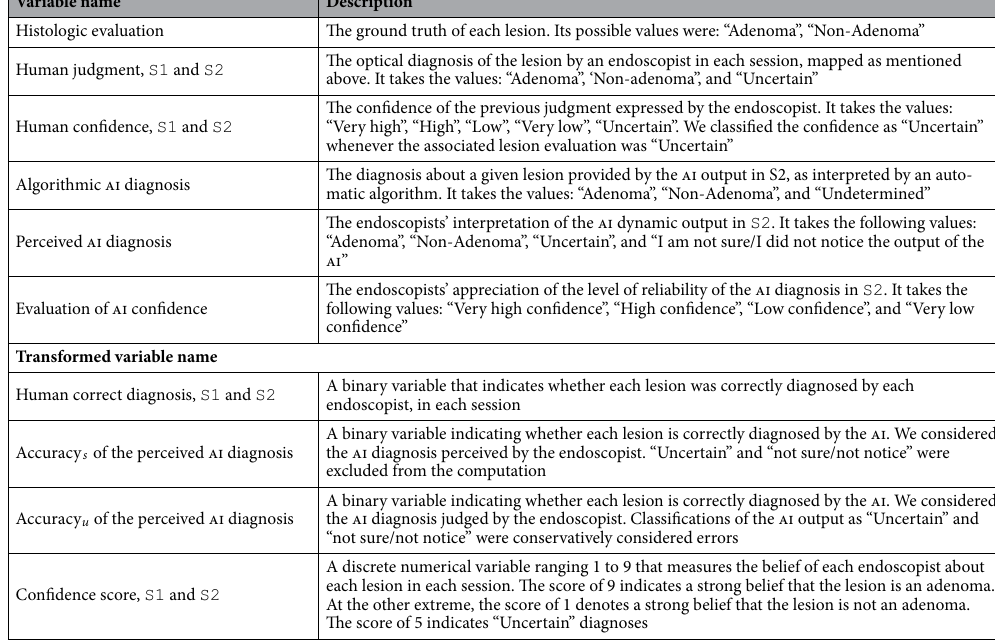
Table 1. Measured and transformed variables for each of the 21 subjects and 504